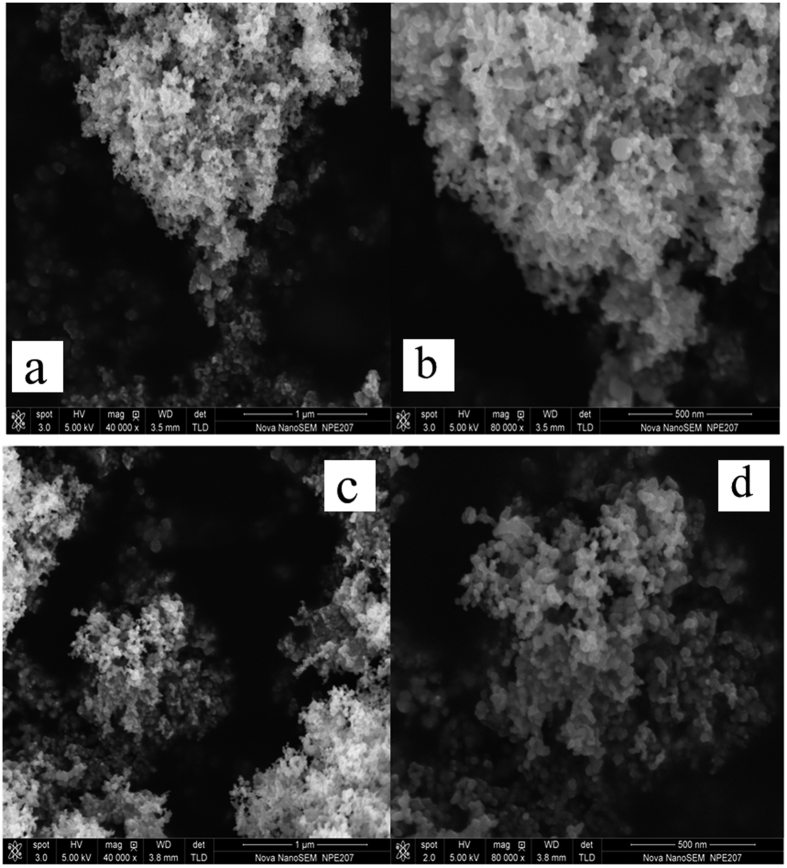
SEM images of (a,b) P25 TiO2 and (c,d) PCN4.